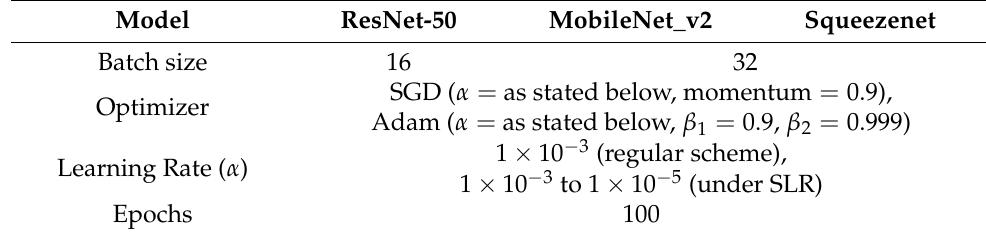
Table 3. Parameters selected for Training